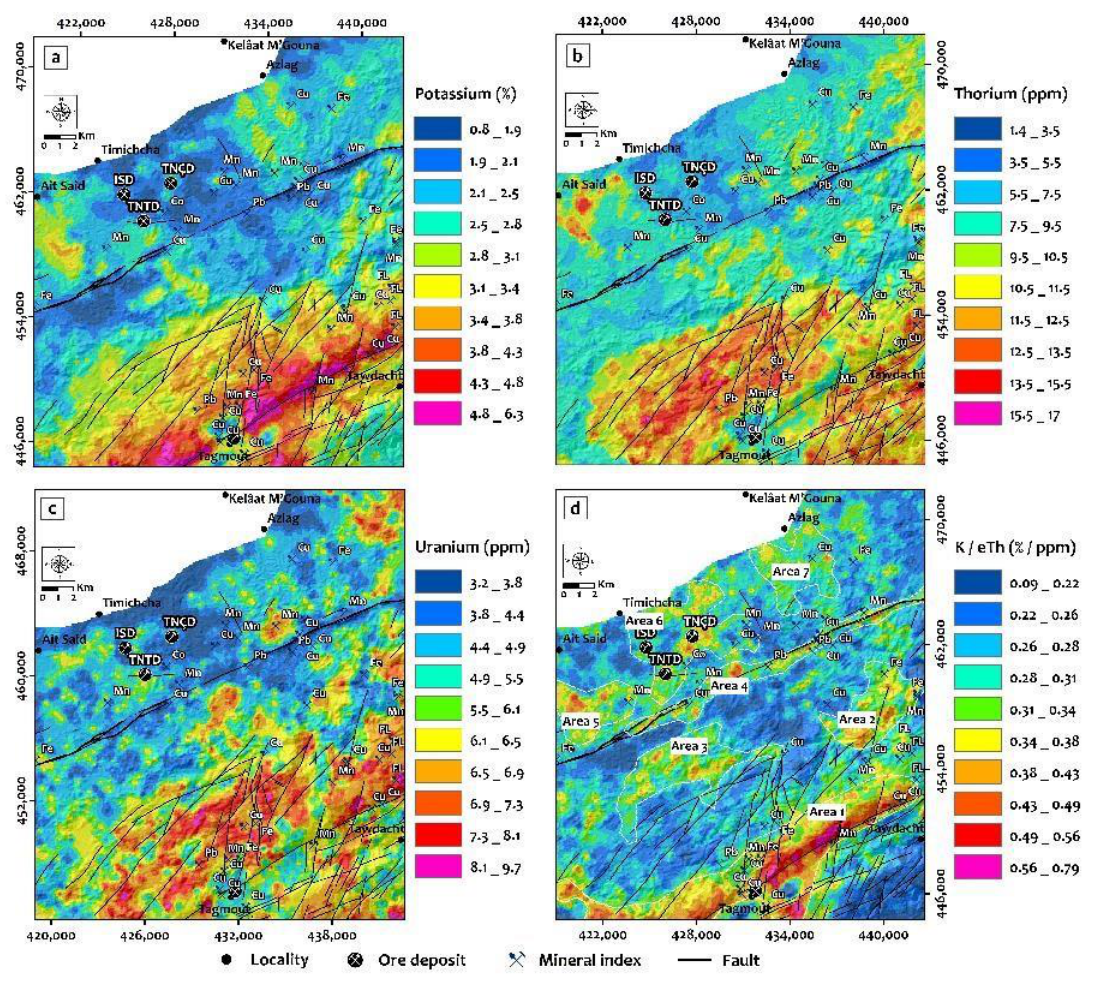
Figure 4. Maps of natural gamma-ray spectrometry showing the distribution of Potassium ( a ), Thorium ( b ), Uranium ( c ), and the ratio K/eTh ( d ).